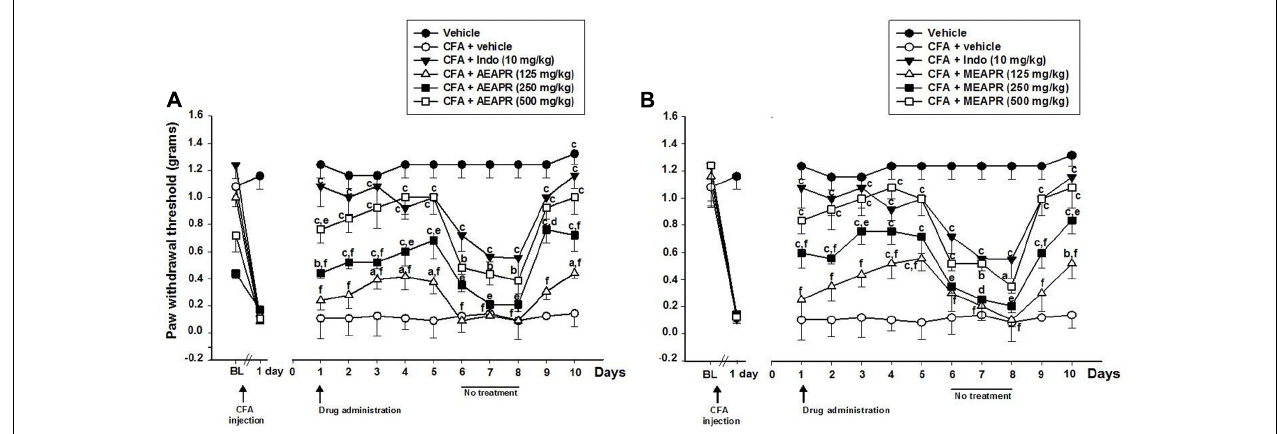
FIGURE 4 | Effect of chronic administration of AEAPR (A) or MEAPR (B) on mechanical hypersensitivity in mice. Animals (six mice each group) were treated orally with vehicle (distilled water), indomethacin (Indo), MEAPR or AEAPR (125, 250, and 500 mg/kg), 24 h after intraplantar injection of Complete Freund’s adjuvant (CFA; 20 µ l). Each point represents the mean ± SEM of the paw withdrawal threshold (in grams) to hind paw stimulation before (basal level: BL), 24 h after CFA injection and at the times (days) indicated after drug administration. The treatment was given once a day for 5 days successively. On the 6th, 7th, and 8th day the drug treatment was avoided and reinitiated for 2 days again in order to evaluate resistance effect of the APR extracts. a p < 0.05, b p < 0.01 and c p < 0.001 in comparison with CFA + vehicle treated group; d p < 0.05; e p < 0.01 and f p < 0.001 in comparison with CFA + indomethacin treated group, using Holm–Sidak post hoc analysis.